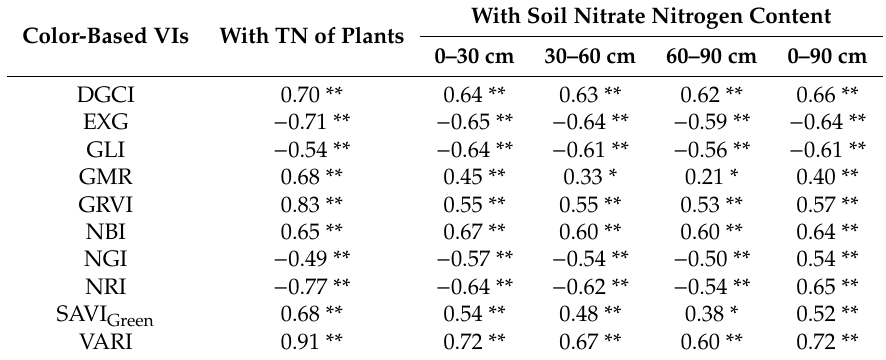
Table 7. Correlation coe ffi cients between color-based VIs and nitrogen status of plant and soil. With Soil Nitrate Nitrogen Content Color-Based VIs With TN of Plants 0–30 cm 30–60 cm 60–90